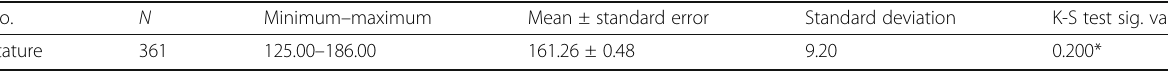
Table 4 Descriptive statistics for age and stature of subjects selected